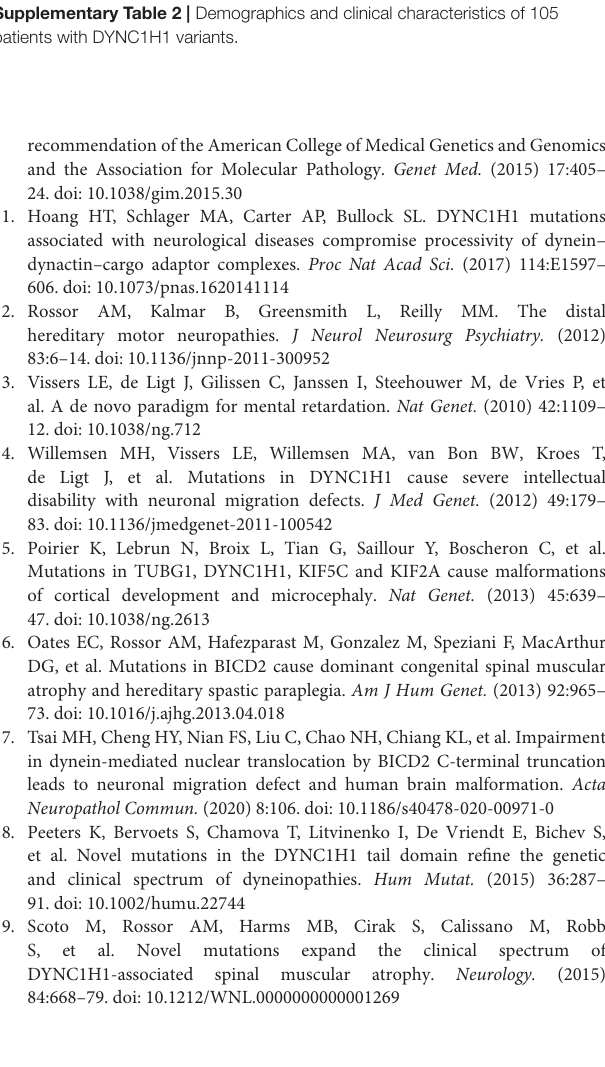
Supplementary Figure 1 | Flow chart of publication screening process. A total of 22 previous publications out of 49 original articles were finally included according to the inclusion and exclusion criteria. Supplementary Table 1 | DYNC1H1 variants associated with neuromuscular diseases in previous publications. Supplementary Table 2 | Demographics and clinical characteristics of 105 patients with DYNC1H1